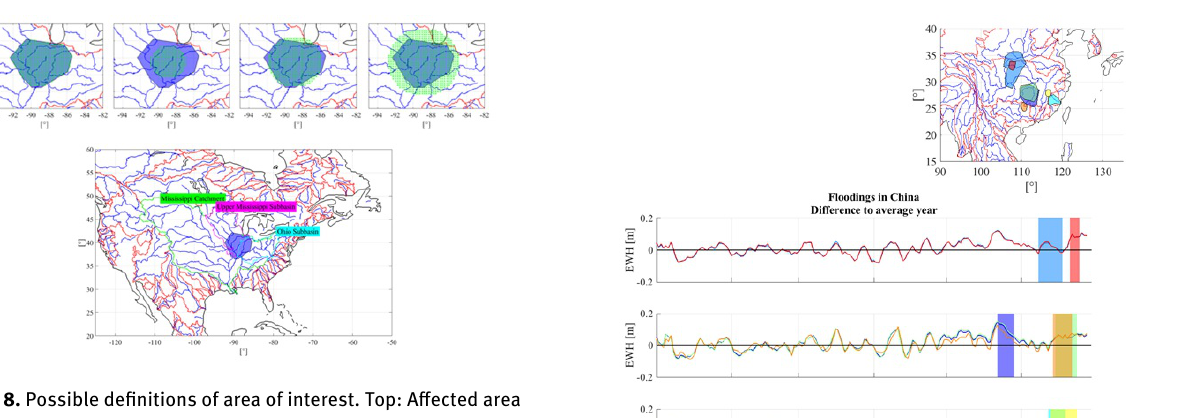
Fig. 8. Possible definitions of area of interest. Top: Affected area (historical data only), circles with R = 2, 3 and 4 arc degrees. Bot- tom: Catchment and Subbasins in the case of the US flooding (ID 1919).